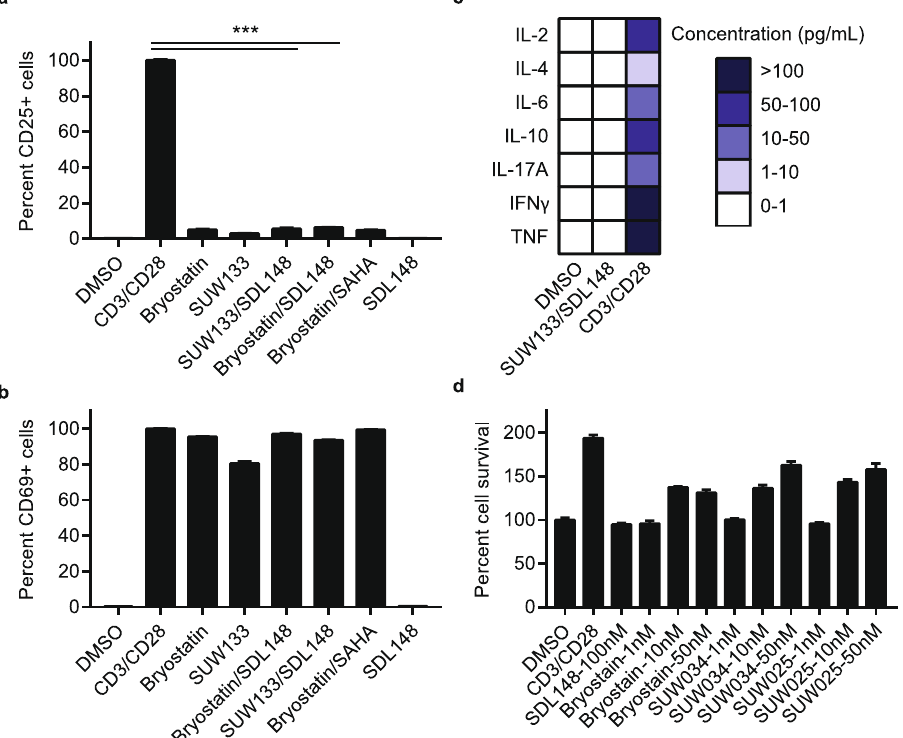
Figure 7. Synergistic combinations avoid global T-cell activation and induction of cytokine release. Resting CD4 + CD25 − T-cells were isolated from a HIV-1 negative donor blood. Cells were incubated 24 h with 1 nM bryologs and 100 nM HDAC inhibitor. Cells were stained with fluorescent-conjugated antibodies (a) CD25- APC and (b) CD69-FITC and analyzed by FACS (see Methods). Data indicate mean values and error bars indicate mean ± s.e.m. (n ≥ 3). *** p < 0.001, (ANOVA). (c) ELISA results for cytokine release from CD4 + CD25- T-cells following 24 h incubation with LRA combinations (see Methods). ( d ) Toxicity profile of LRA combinations. Resting CD4 + T-cells were incubated with compounds at indicated concentrations and MTT toxicity assay was performed as described in